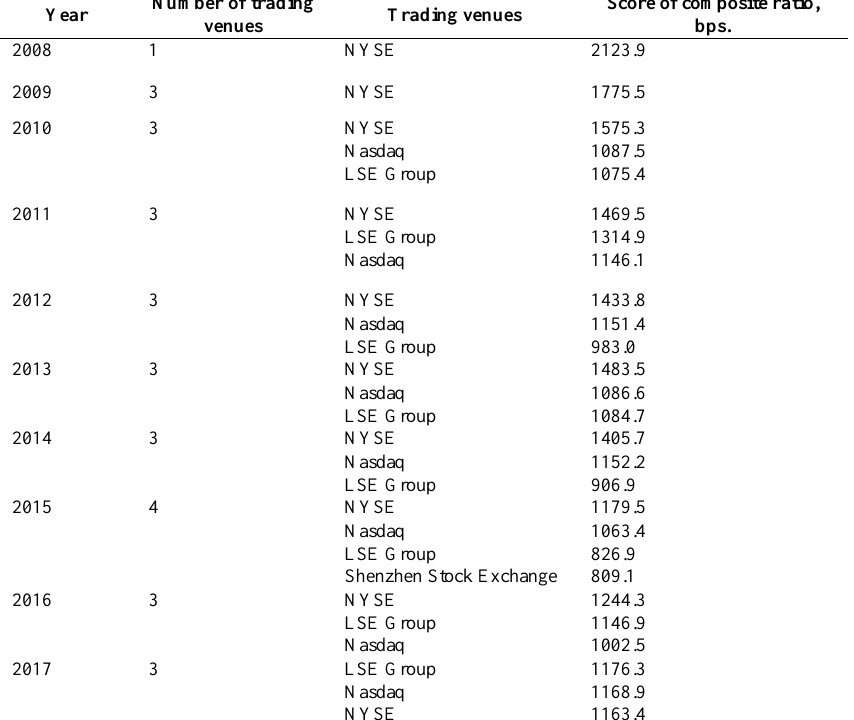
Table 3. Global systemically important trading venues by composite ratio